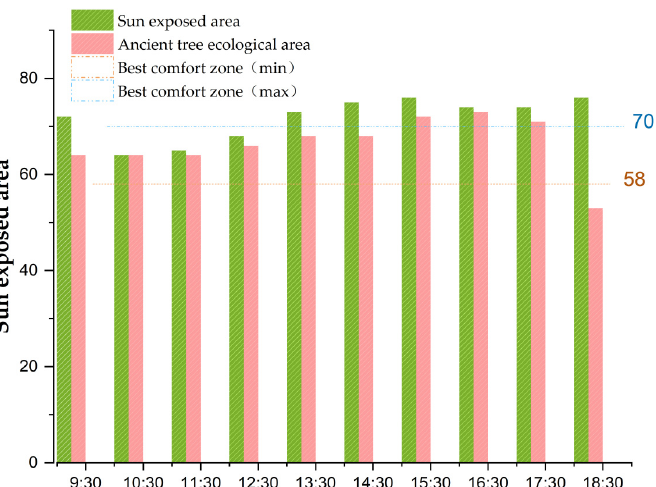
Figure 11. Numerical trend of somatosensory sense and comfort. Source: Origin 2021 software production. 58–70 is the best comfort zone, 50 − 80 is the comfort zone.